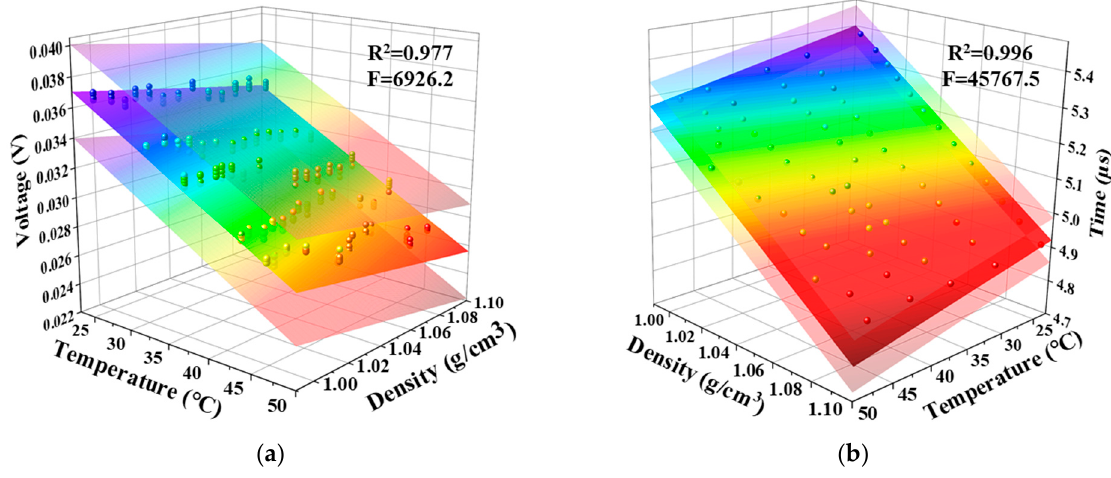
Figure 5. Binary linear regression models of ρ and T via measured ( a ) V and ( b ) t .